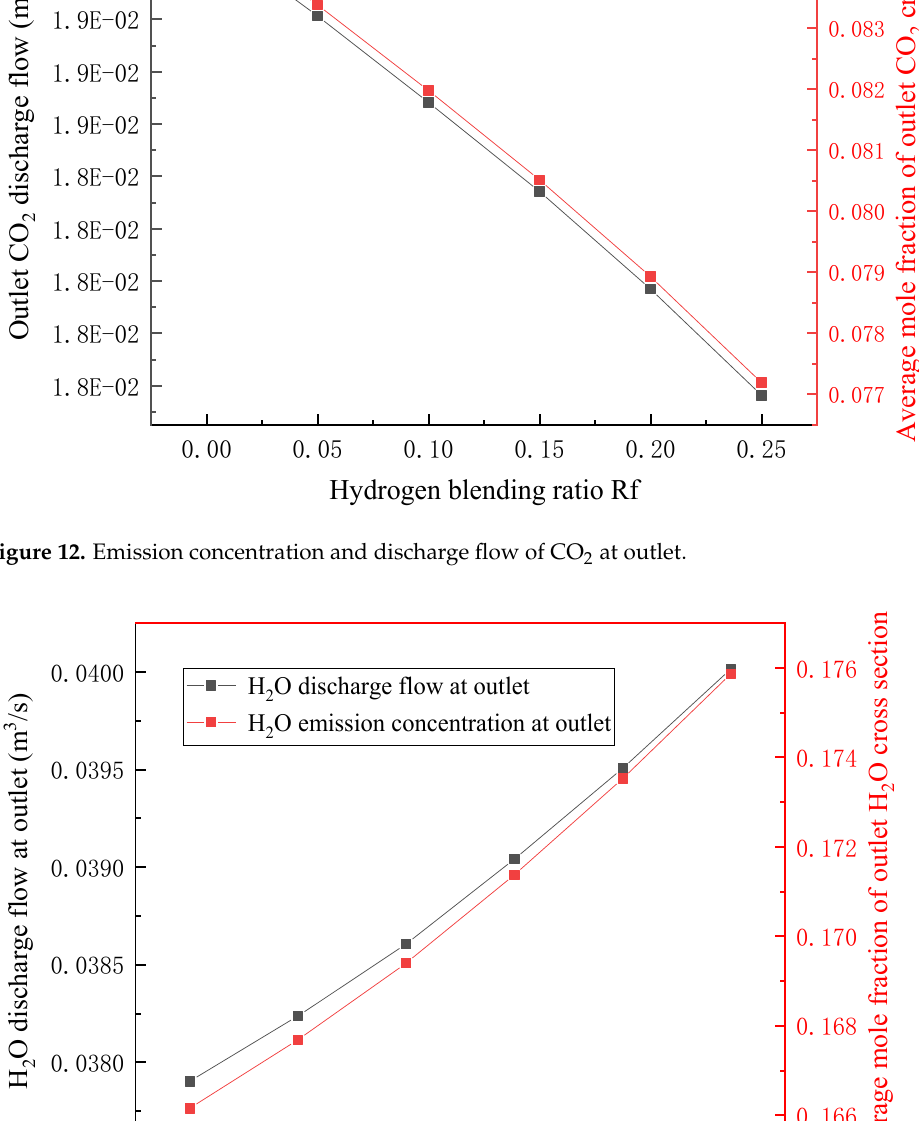
Figure 13. Emission concentration and discharge flow of H 2 O at outlet.